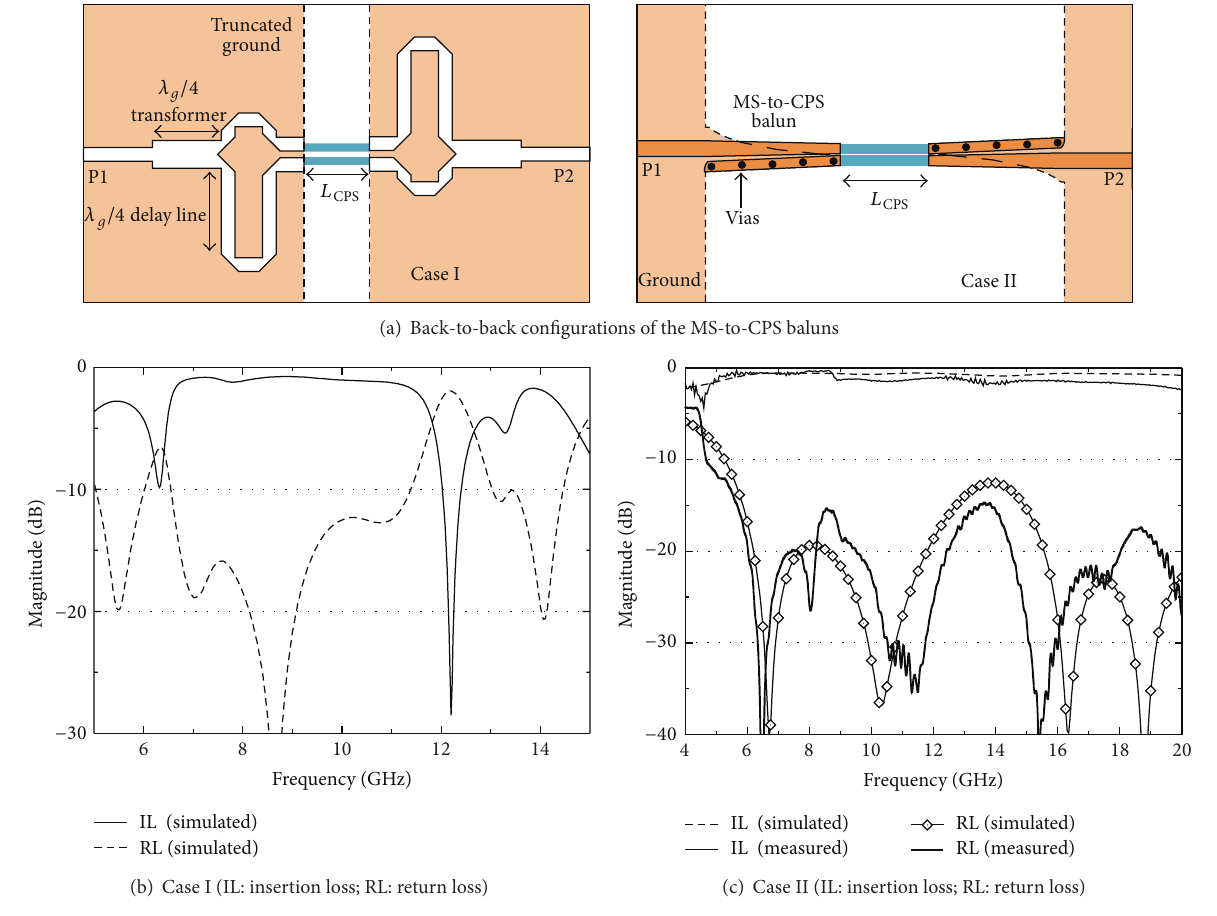
Figure 2: Back-to-back analysis of the MS-to-CPS